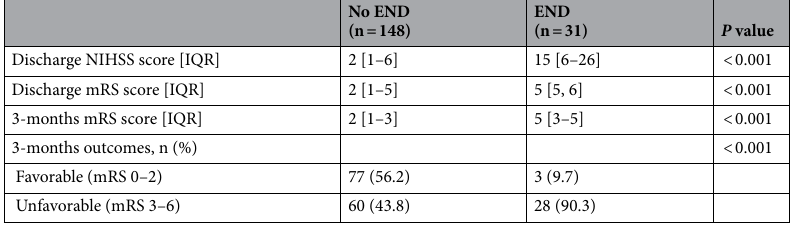
Table 5. Outcomes between patients with and without early neurological deterioration. END = early neurological deterioration, NIHSS = National Institutes of Health Stroke Scale, mRS = modified Rankin Scale.